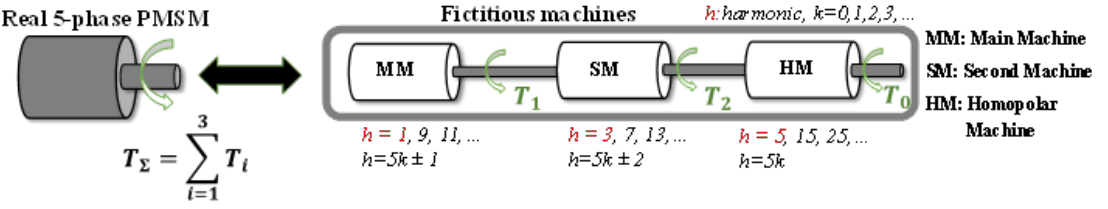
Figure 19. Three fictitious machines and associated groups of harmonics of a five-phase PMSM.